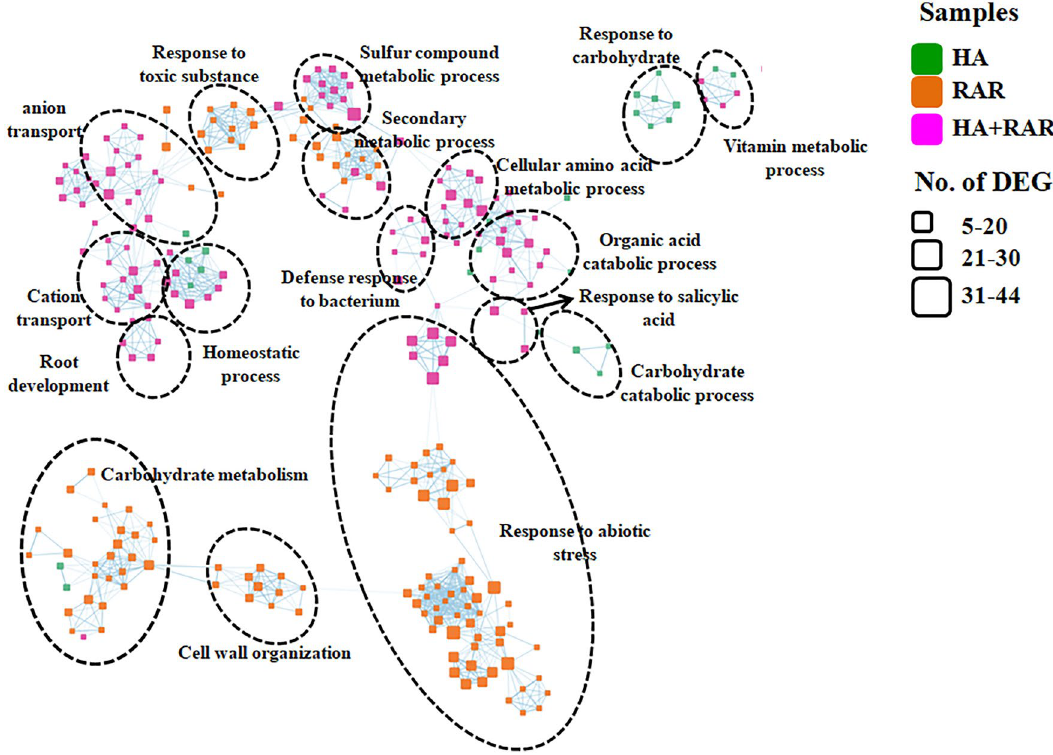
Figure 5. Functional enrichment analysis of the HA, RAR and HA + RAR treatments and its interactome analyses uncovers functional significance in these three samples. Node colour represent the different sample such as green, orange and pink colour showing the HA, RAR and HA + RAR samples. The size of the nodes shows the number (setSize) of differentially expressed genes identified in